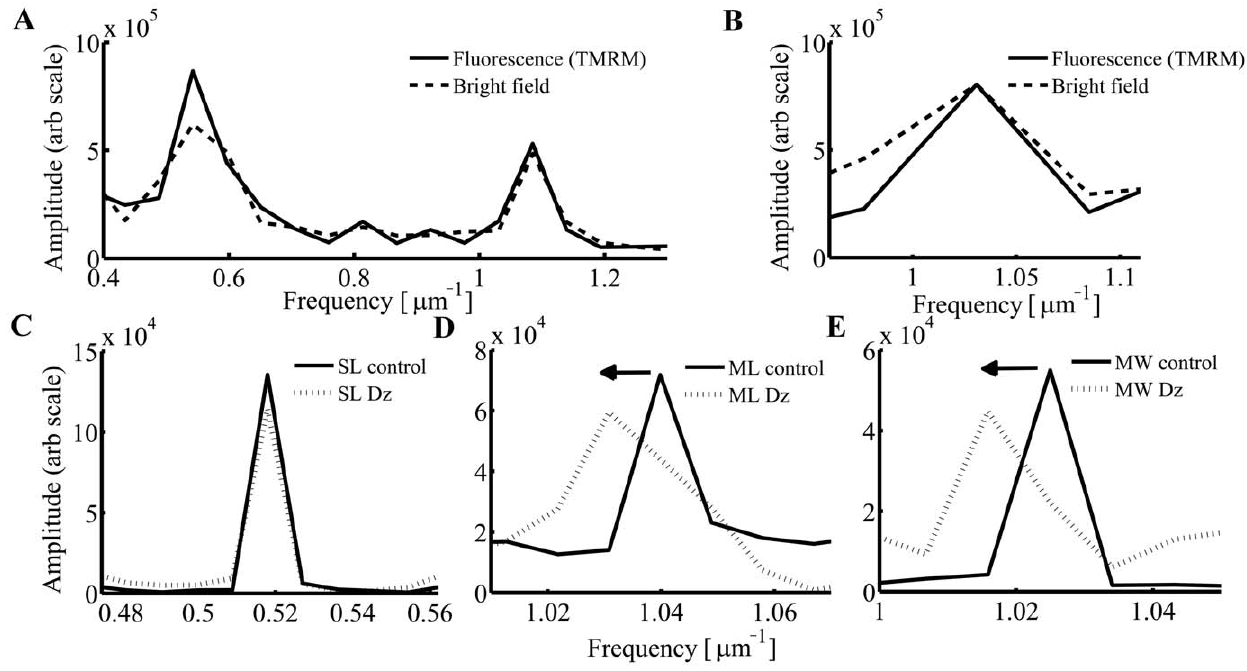
Figure 3. Cardiomyocyte structural determinants of principal Fourier transform spectral peaks: assignment and validation. Consecutive Fourier analysis along length (A) and width (B) directions calculated from bright field and fluorescence images of tetramethylrhodamine methyl ester (TMRM) loaded cardiomyocytes. Low concentrations of diazoxide (Dz; 30 m M) did not shift the sarcomere peak (C), but shifted the frequency of the mitochondrial peak (D) along the length-axis and (E) width-axis to the left by , 1%. doi:10.1371/journal.pone.0021985.g003 mitochondrial length during the same intervals, derived from the principal contractile parameters (Table 1) of the SL and mitochon- period of the second (higher frequency) peak. Along the length-axis, drial diameter along the length-axis were the same, except for the both structures shortened (compressed) during contraction. The extent of deformation and resting dimensions. Note that the two-fold